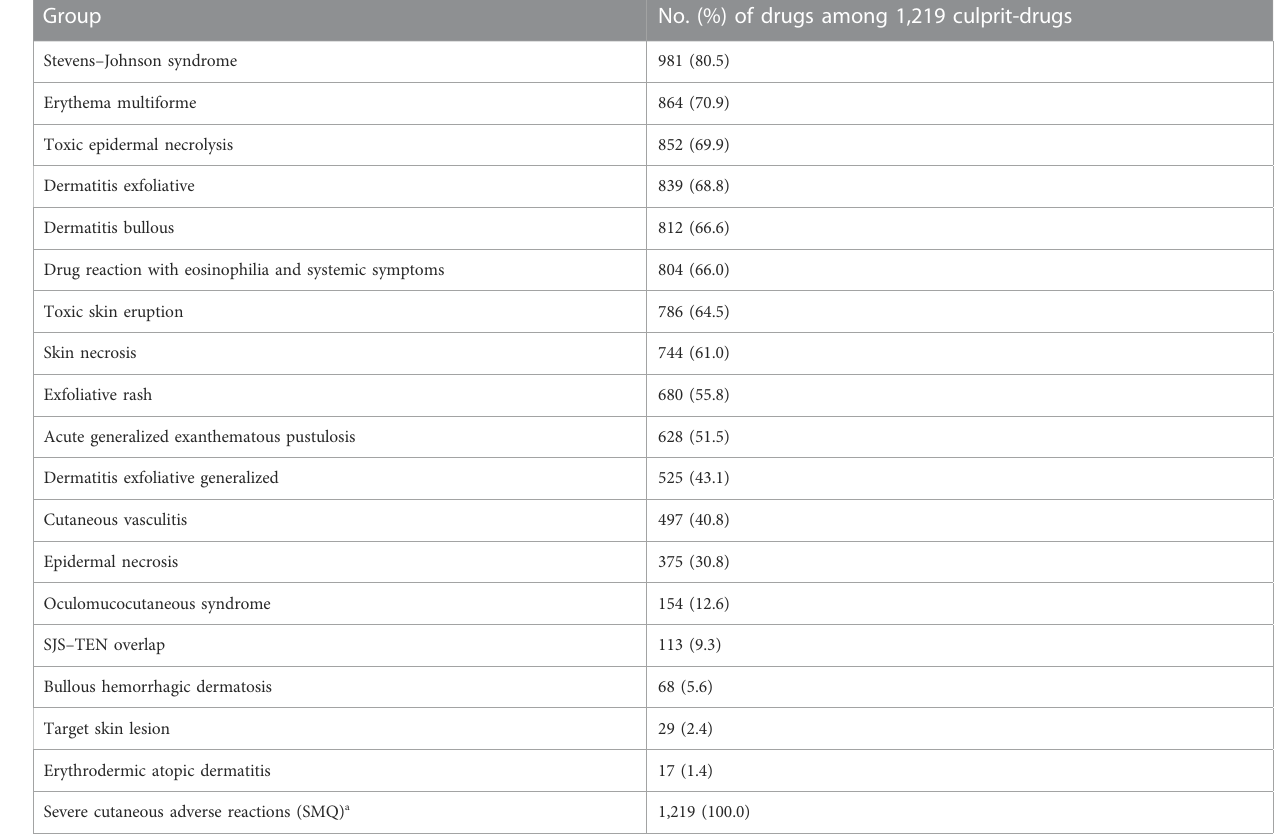
TABLE 3 Number of culprit-drugs of the SMQ group and each PT subgroup.